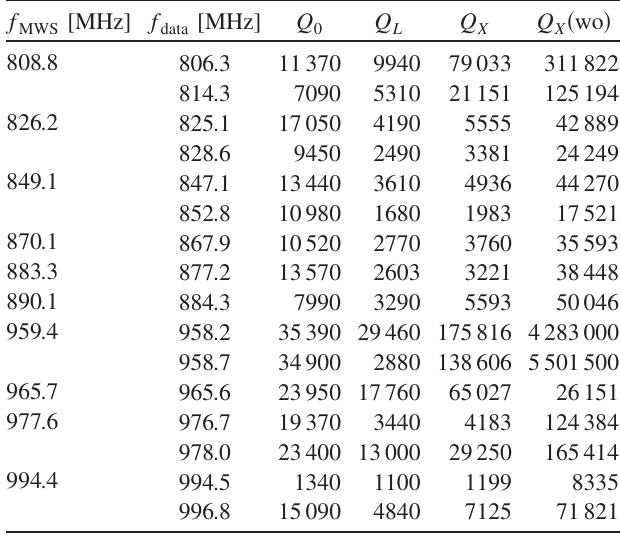
TABLE III. Simulated and measured frequencies and mea- sured Q values of the cavity with one ring. Q X is from Q 0 and Q ð wo Þ is for probes with equal length but without disk. The Q L X external Q at the fundamental is (cid:1) 10 8